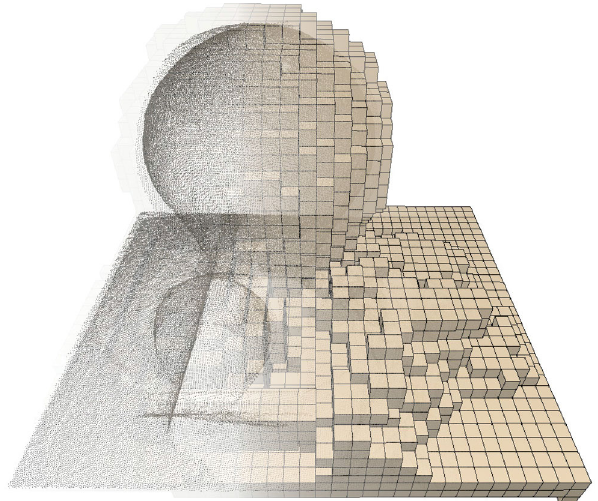
Fig. 5 Visualization of blocks to be reconstructed. Left side shows the input point cloud and the right side shows the corresponding non-empty